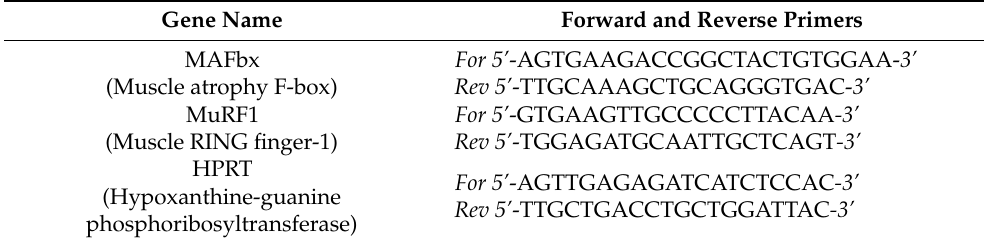
Table 3. Primer sequences used for quantitative analysis of gene